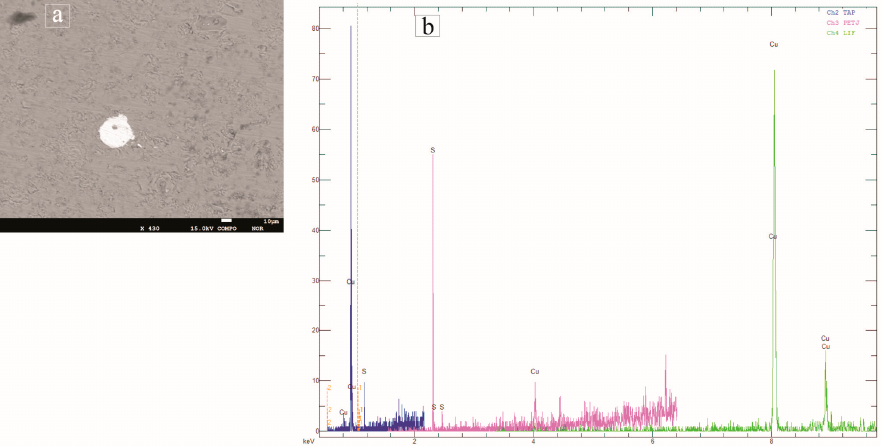
Figure 9. ( a ) Backscattered electron image showing a micrometric crystal of copper sulphide embedded in the homogeneous glass matrix of the red QsR1 tessera; ( b ) Spectrum of copper sulphide by EPMA-WDS qualitative analysis.